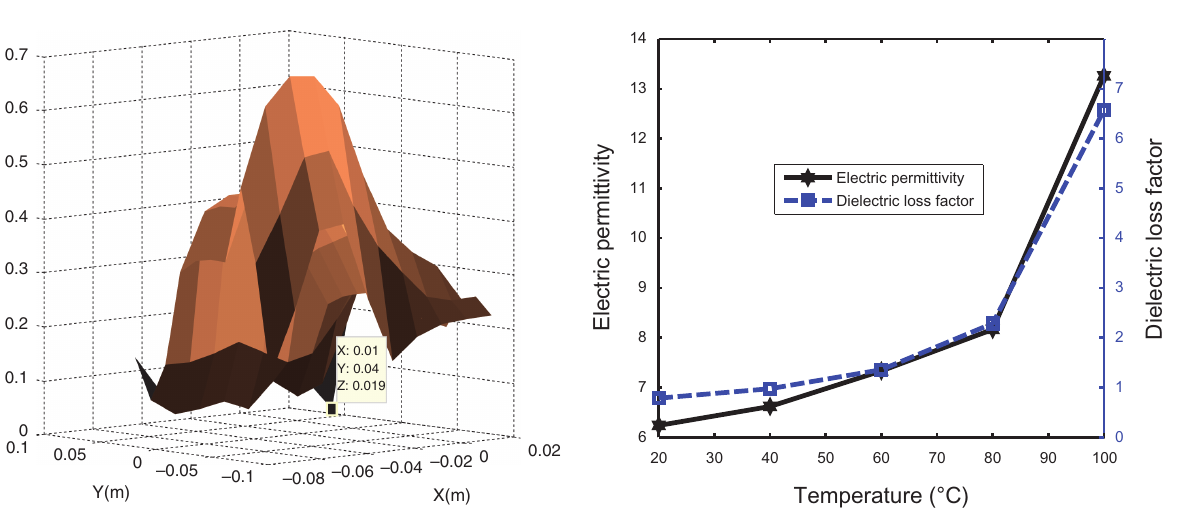
Figure 5: Variation of complex dielectric permittivity of titanium concentrate with temperature at 2.45GHz.